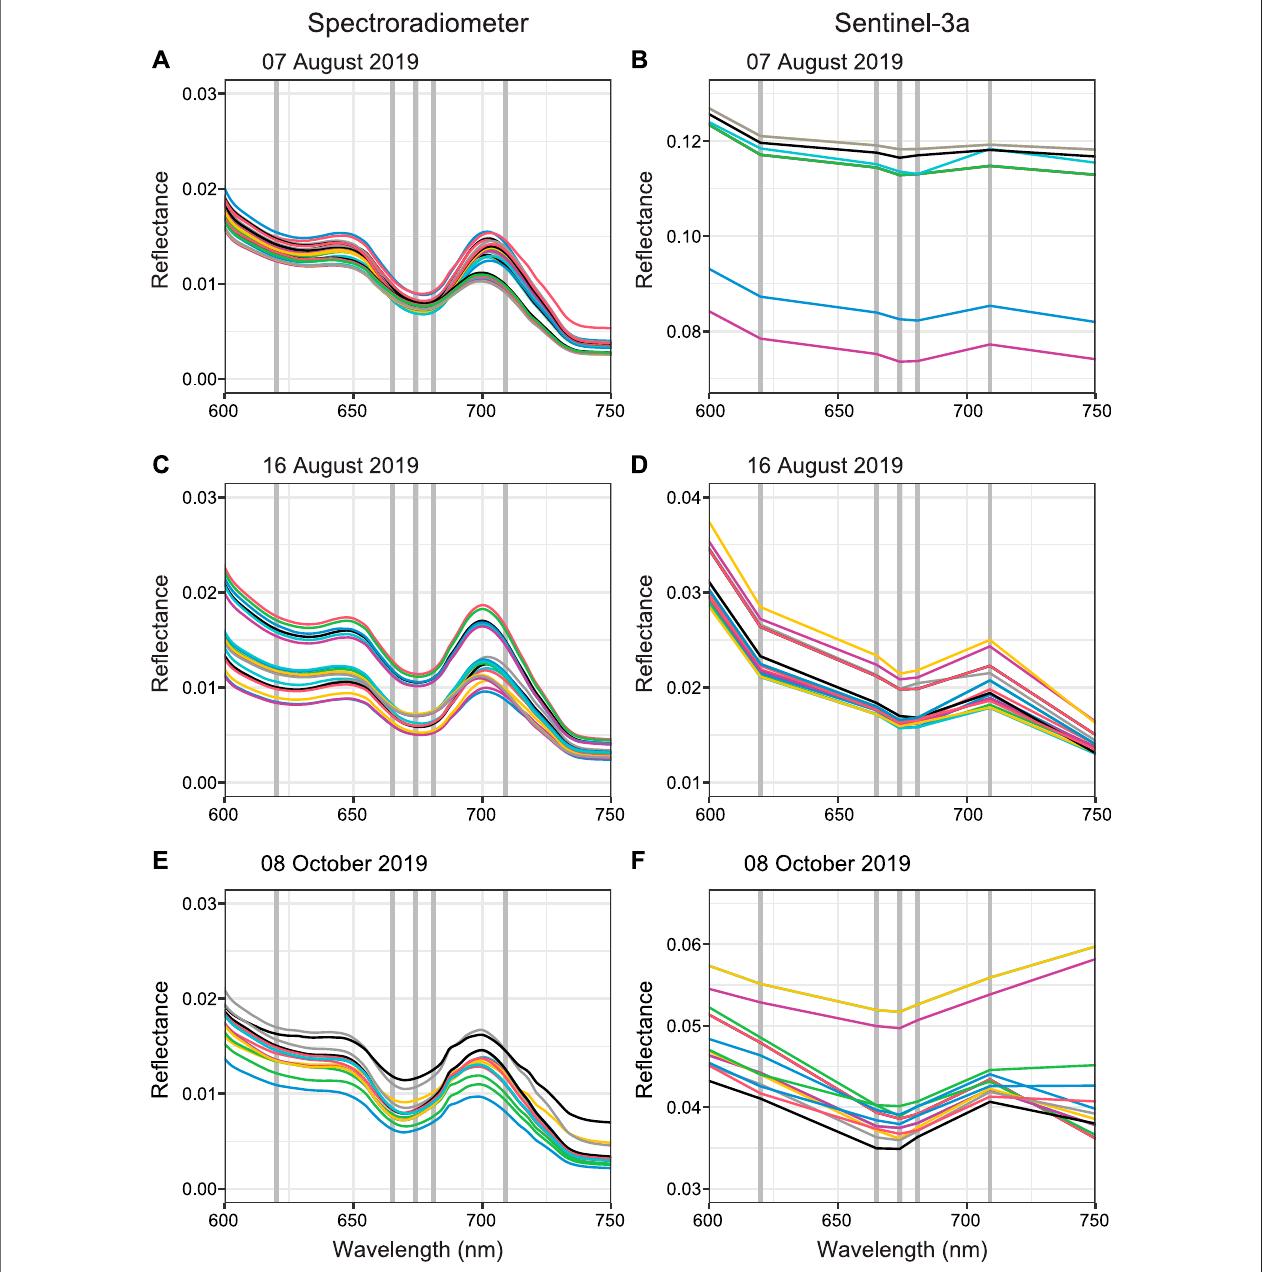
FIGURE 3 | Spectra from in situ spectroradiometer (A, C, E) and Sentinel-3 pixel data (B, D, F) for different sampling dates (A – B) August 07, 2019 (C – D) August 16, 2019, and (E – F) October 08, 2019. The fi eld spectra demonstrate spectral features for phycocyanin and chlorophyll- a which are less discernable in the coarser satellite data.Each colored linerepresented theresults from adifferentdiscrete samplesite(n (cid:2) 61 totalover three samplingdates)for thespectroradiometer dataand a differentpixel(n (cid:2) 42totaloverthreesamplingdates)forsatellitedata.TheverticalgraylinesrepresentthespectralbandcentersofSentinel-3a.Notethedifference in the y -axis range between the re fl ectance plots. Re fl ectance is dimensionless.